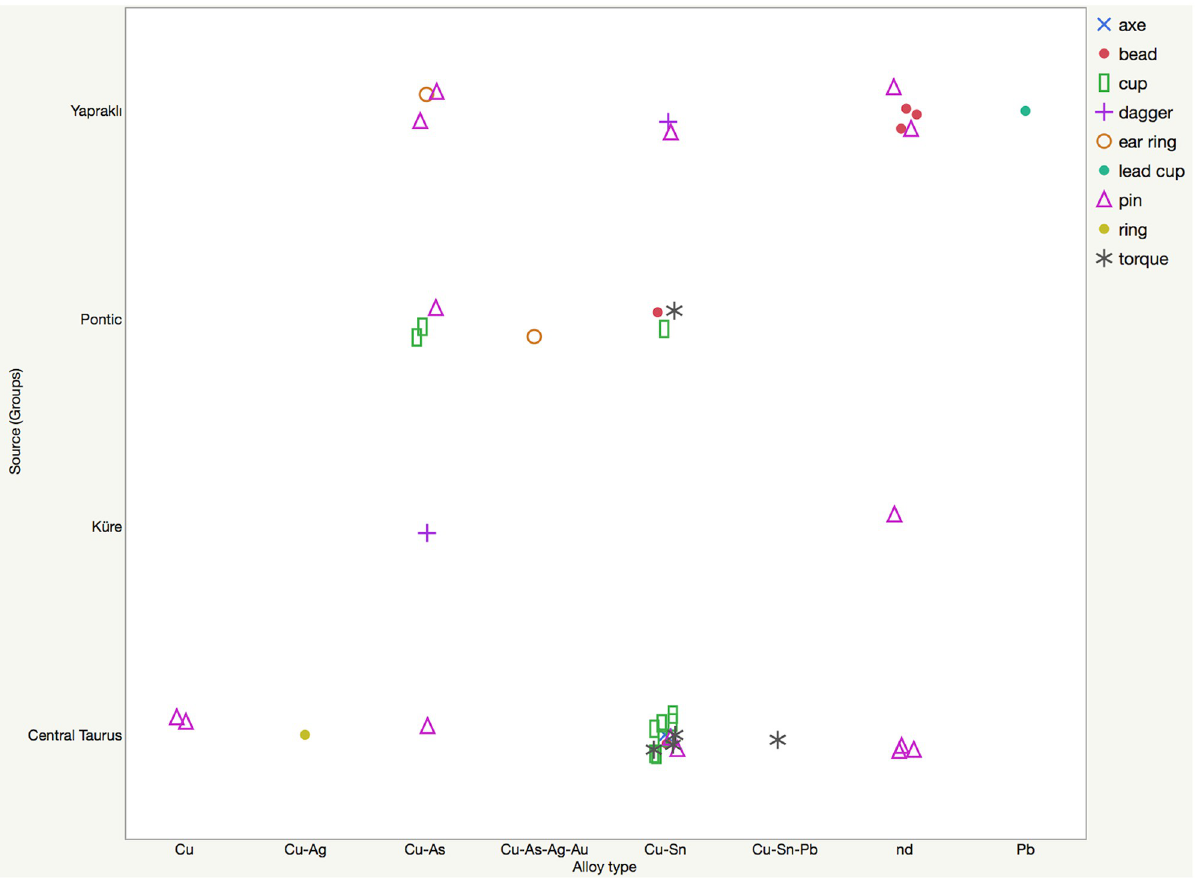
Fig 13. Graphical representation of alloy type versus provenance; object types are provided in the